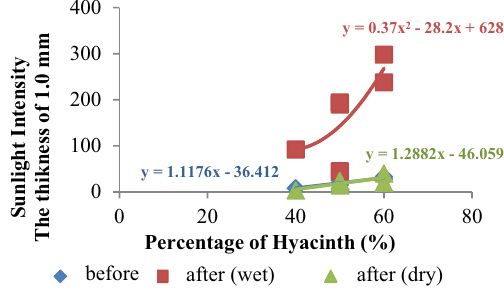
Fig. 8 The correlation between sunlight intensity and the percentage of banana pseudostem in 1.0 mm organic mulch sheet